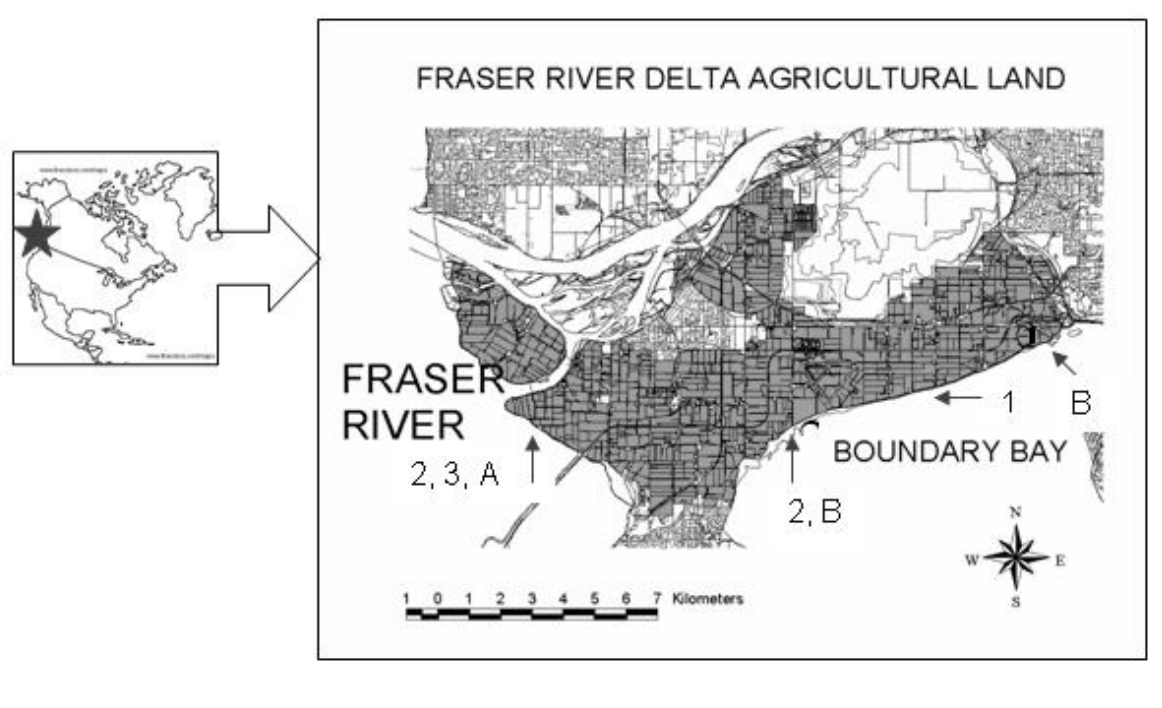
Fig. 1 . Agricultural lands in the Fraser River Delta (gray shading). Arrows indicate locations of Dunlin capture and invertebrate sampling. Numbers indicate year of sampling for Dunlin commencing 1997–1998. Letters indicate type of invertebrates sampled: A = terrestrial invertebrates, B = estuarine